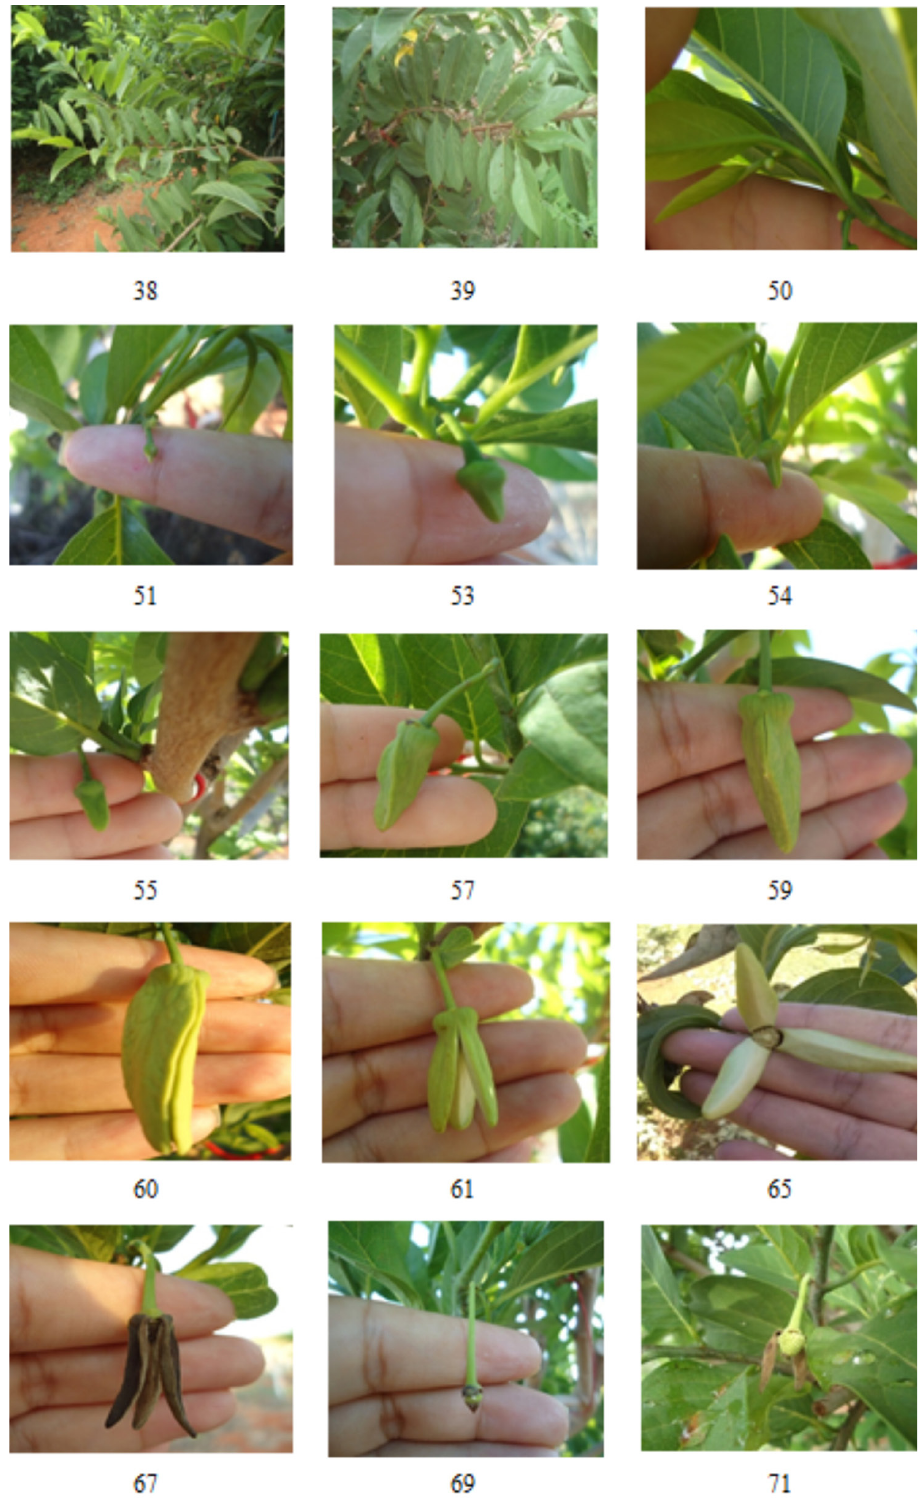
Figure 3 - Principal growth stages (38-71) of sugar-apple ( A. squamosa L.) as described by the BBCH scale in Janaúba, Minas Gerais,